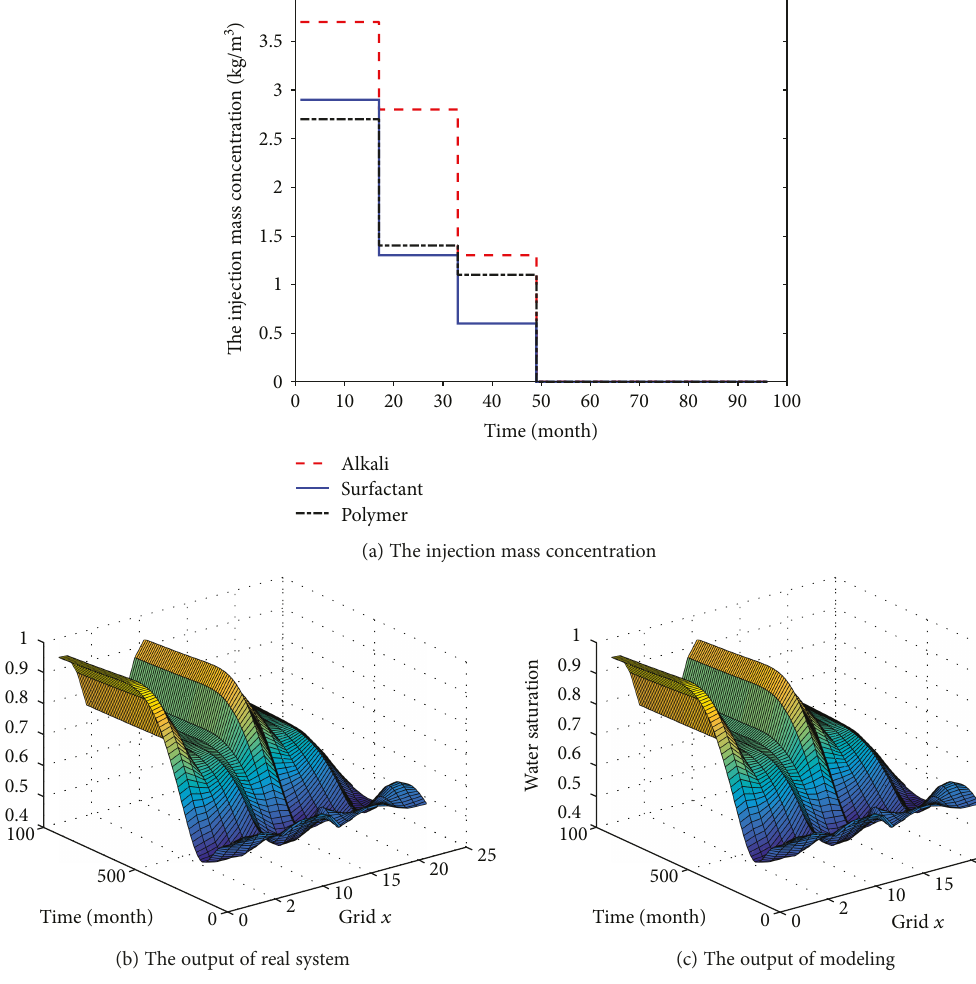
Figure 8: Comparison diagram of water